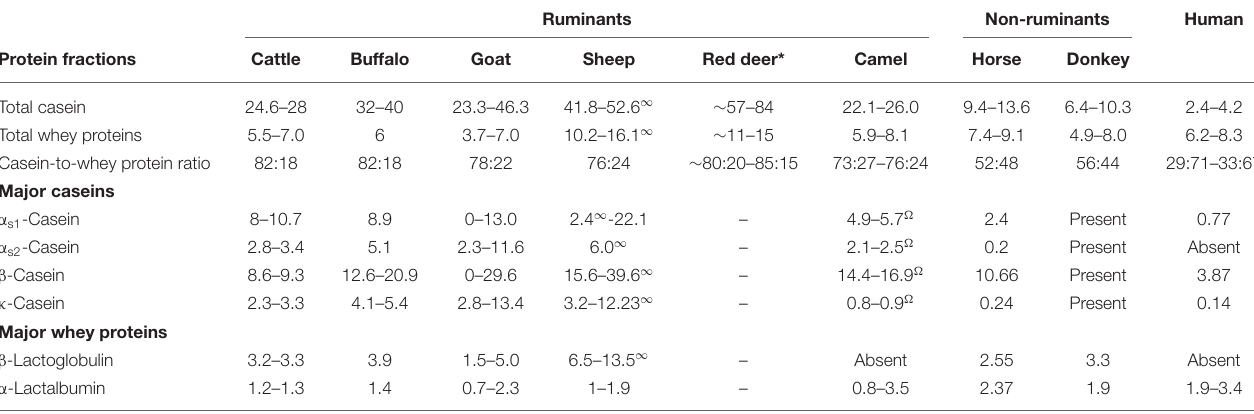
TABLE 2 | Protein profile (g L − 1 ) of milk from different mammalian species #